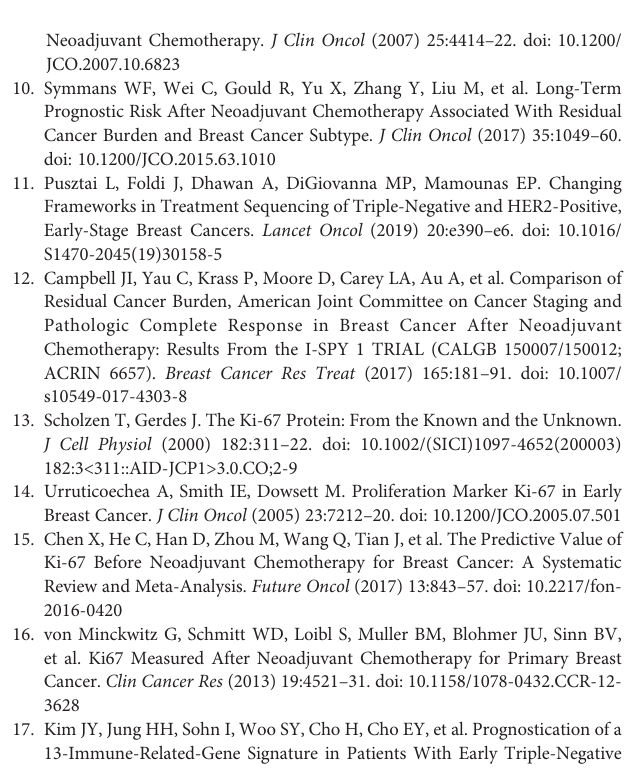
Supplementary Figure 1 | Disease free survival according to Ki-67 in (A) RCB class I, (B) RCB class II and (C) RCB class III and overall survival according to Ki-67 in (D) RCB class I, (E) RCB class II and (F) RCB class III. Supplementary Figure 2 | Disease free survival according to (A) RCB class and (B) Ki-67gradeandoverallsurvivalaccordingto (C) RCBclassand (D) Ki-67grade. Supplementary Figure 3 | AUC according to 3year ’ s disease free survival in (A) RPCB class (B) RCB class and (C) Ki-67 grade and AUC according to 3 year ’ s overall survival in (D) RPCB class (E) RCB class and (F) Ki-67 grade. Supplementary Figure 4 | DFS according to RCB class in (A) HR+HER2- BC (B) TNBC (C) HER2+ BC and OS according to RCB class in (D) HR+HER2- BC (E) TNBC (F) HER2+ BC. Supplementary Figure 5 | DFS according to post op Ki-67 in (A) HR+HER2- BC (B) TNBC (C) HER2+ BC and OS according to post op Ki-67 in (D) HR+HER2- BC (E) TNBC (F) HER2+